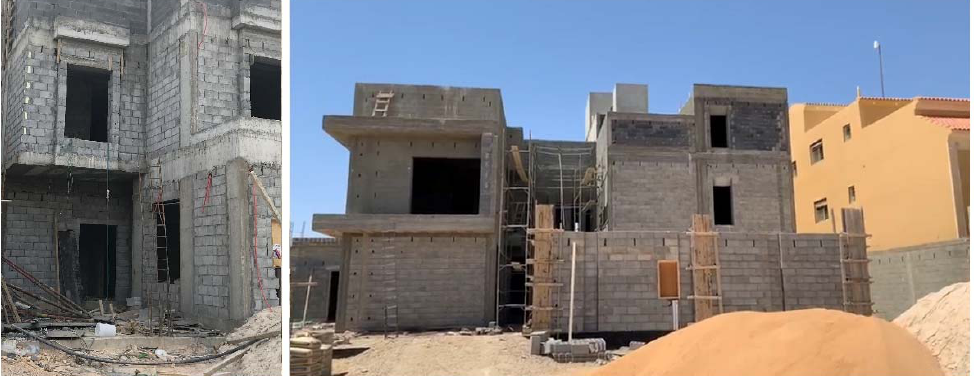
Figure 1. Concrete frame construction with block in-fill and example of villa-style housing develop- ment in Saudi Arabia.